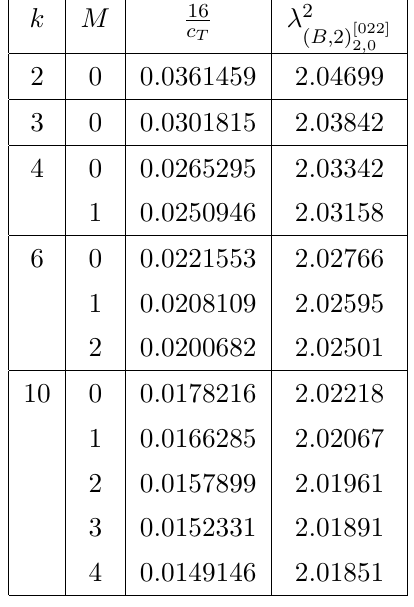
and λ 2 in various U(10) k × U(10 + M ) − k ABJ theories, as c T ( B, 2) [022] 2 , 0